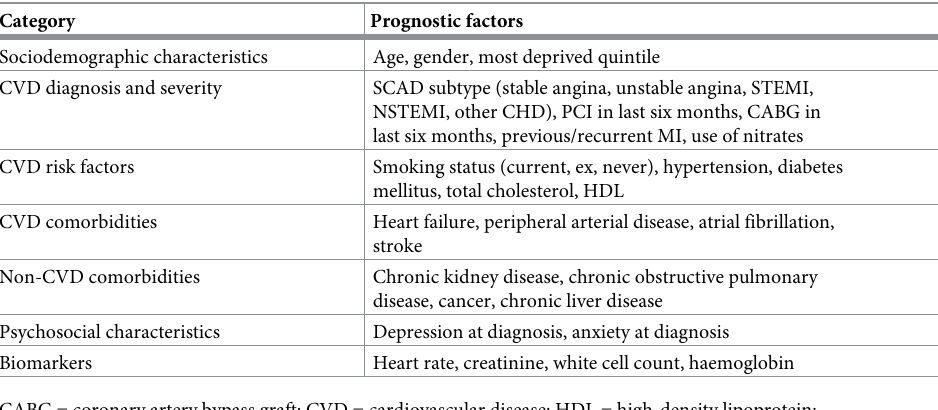
Table 1. The 27 expert-selected predictors used.